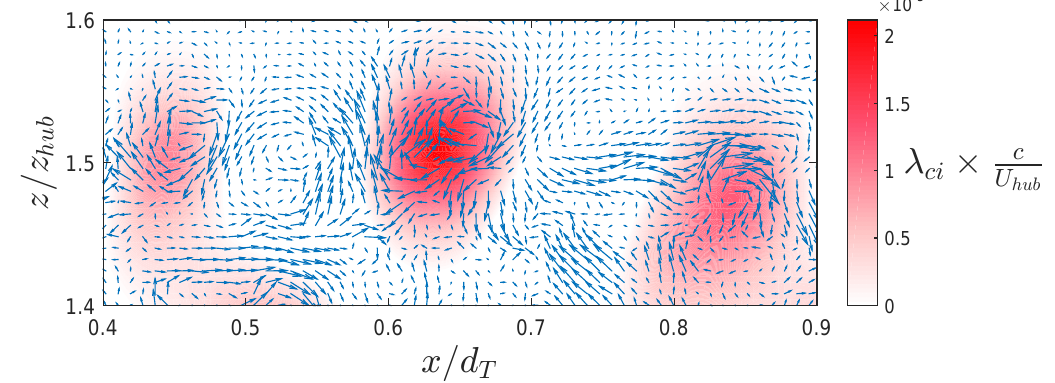
(red area) to illustrate the ci